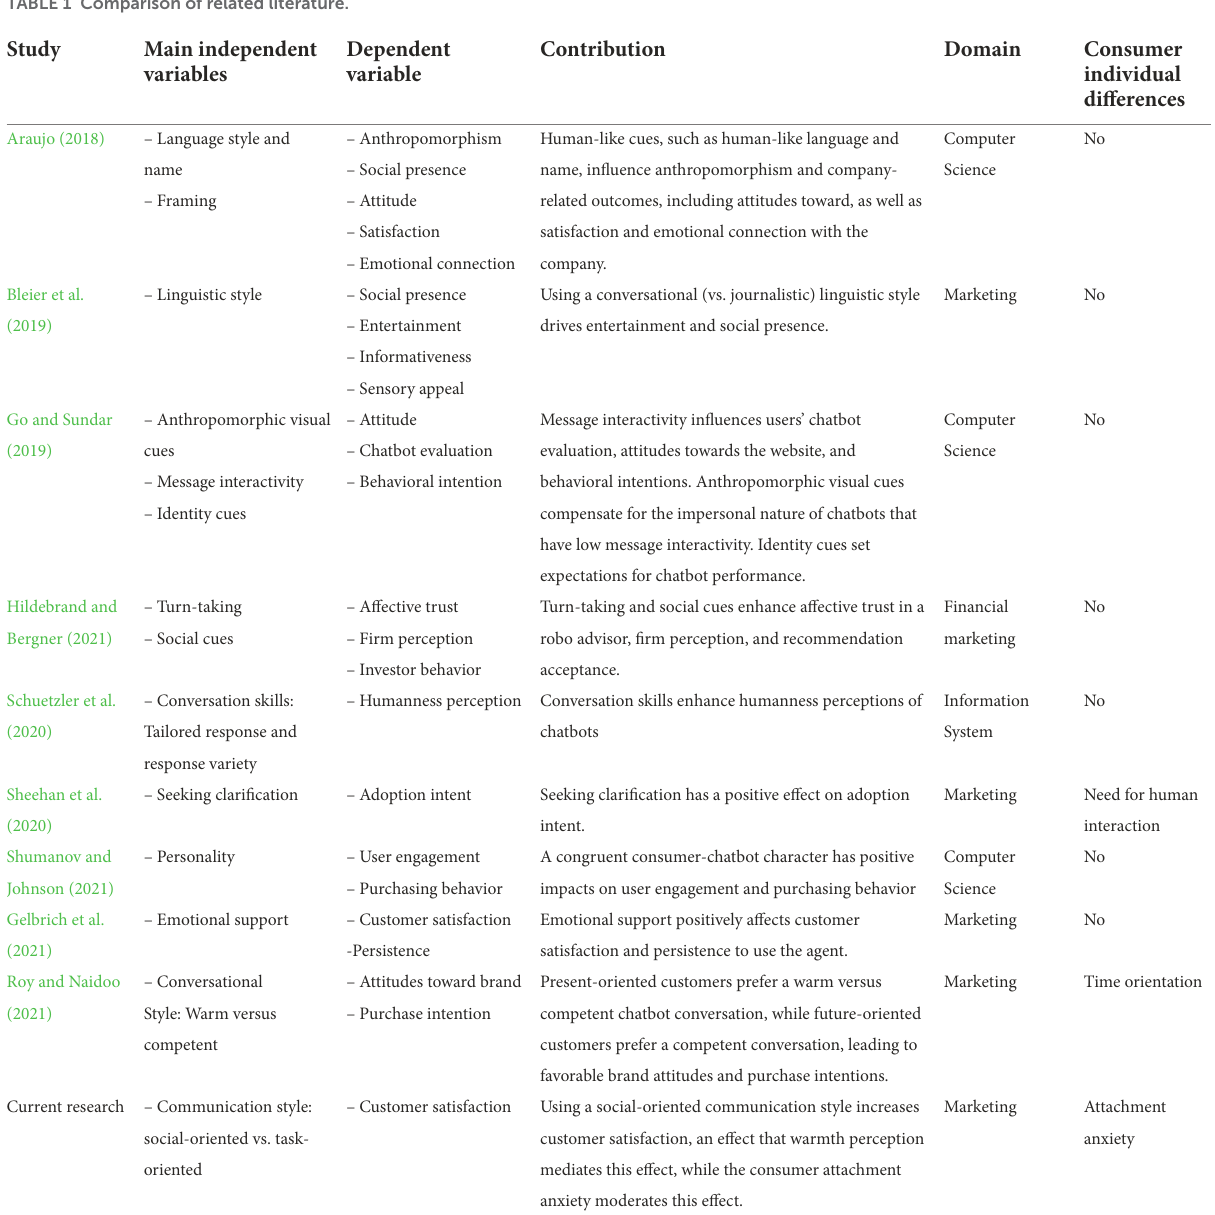
TABLE 1 Comparison of related